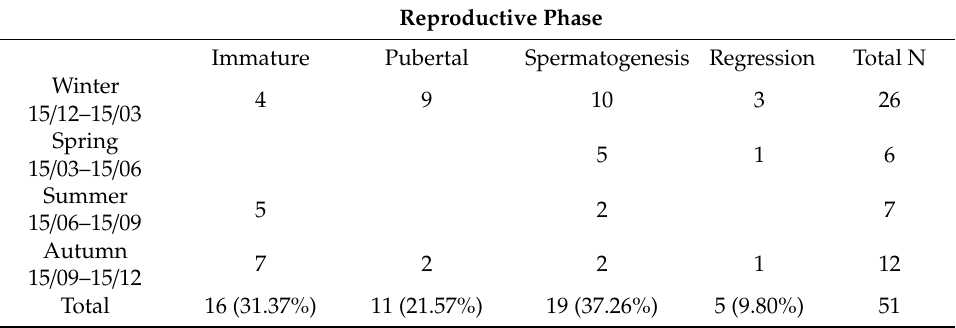
Figure 5. Images of epididymis in different reproductive phases. ( a ) Immature phase: the diameter of the epididymis is small and the lumen is empty. ( b ) Spermatogenesis phase: the diameter of the epididymis is larger and it is full of spermatozoa. ( c ) Regressive phase: cell debris and squamous cells can be observed in the epididymis lumen. Table 5. Seasonal distribution of male squirrels according to their reproductive status.